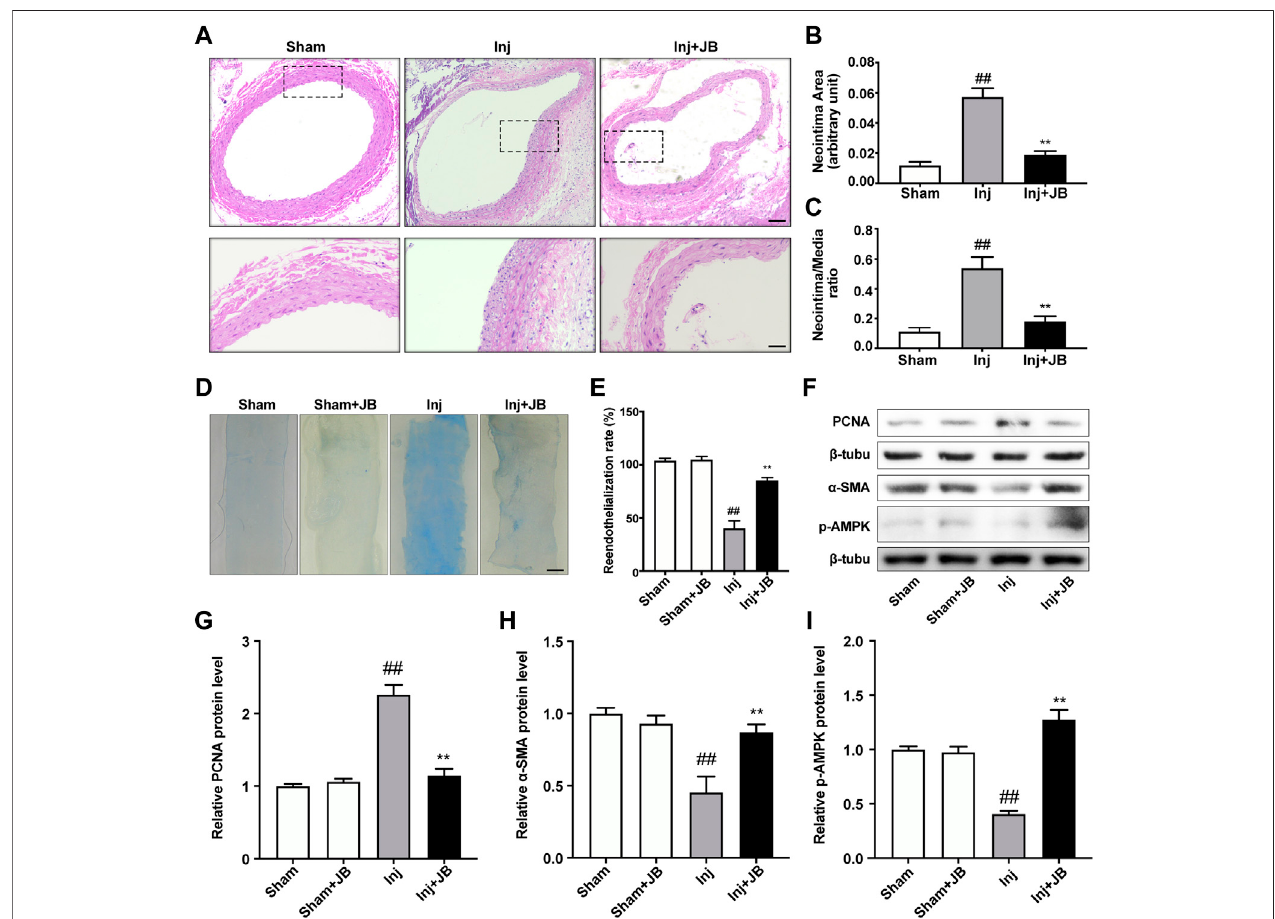
FIGURE2| TherapeuticeffectofJBonrestenosisafterballooninjury invivo . (A) Representativesectionimagesoftheleftcommoncarotidarteryinsham-operated rats and balloon-injured rats on day 14 after operation with or without JB treatment. Scale bar: 100 μ m (the upper panel), 50 μ m (the lower panel). (B,C) Quantitative studyontheareaoftheintimaandtheratioofintimatomedium(I/M)ofleftcommoncarotidarteryinSDrats. (D) Evansbluestainingimagesofleftcommoncarotidartery in shamoperated ratsand ballooninjuredratson the14th day after operation. Scalebar: 1 mm. (E) Comparison ofreendothelializationrateofleftcommoncarotid arteryineachgroup. (F) WesternblottinganalysisofPCNA, α -SMAand p -AMPKinleftcommoncarotidarteryofsham-operatedratsandballoon-injuredratsonthe14th dayafteroperationwithorwithoutJBtreatment. (G – I) Quanti fi cationofPCNA (G) , α -SMA (H) ,p-AMPK (I) proteinexpressionlevelsbetweengroups.Dataareexpressed as mean ± S.D. ## p < 0.01 vs. Sham group. ** p < 0.01 vs. Inj group. n (cid:1) 6.